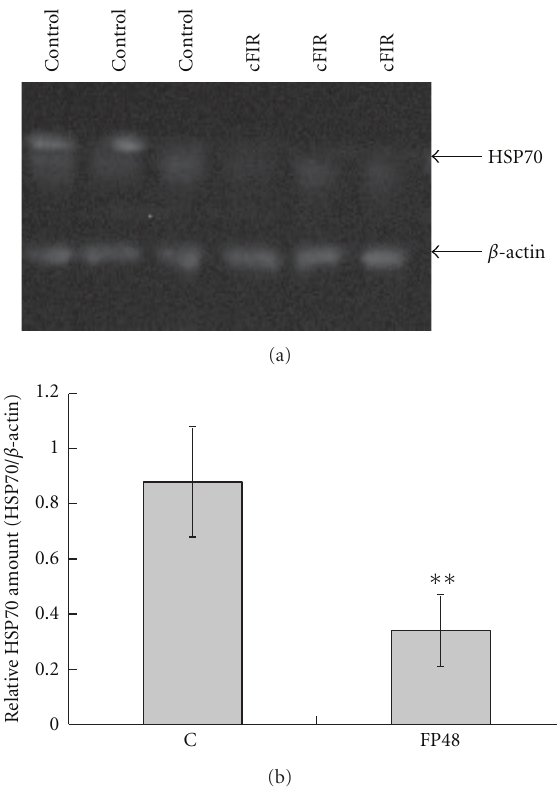
Figure 3: Comparison of intracellular HSP70 levels between the control (group C) and cFIR (group FP48) groups. (a) Western blot- ting gel. (b) The mean and standard deviation of the normalized HSP70 amount (Wilcoxon test).